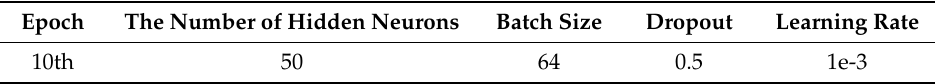
Table 3. Hyper-parameters